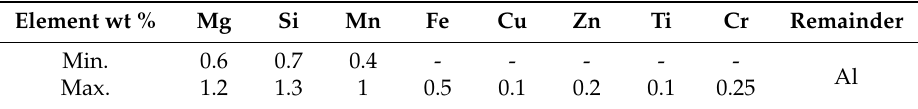
Table 1. Main chemical composition of AA6082.